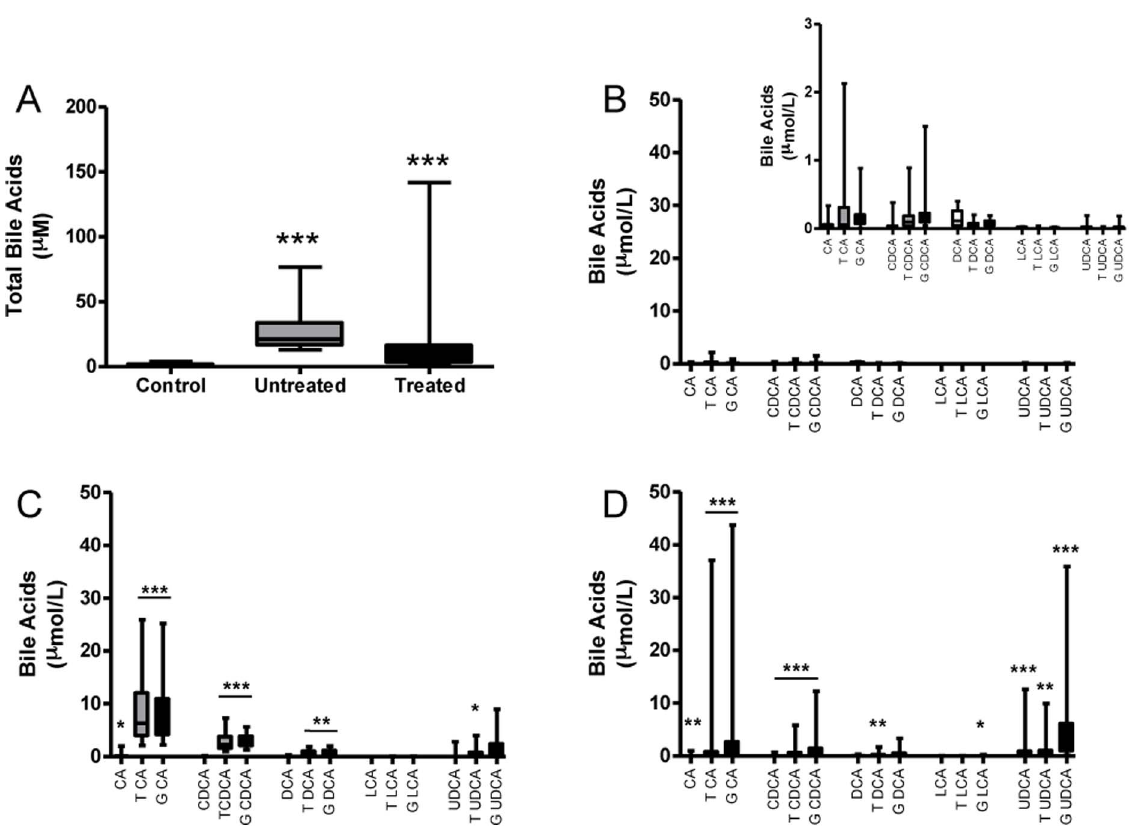
Figure 1. Total serum bile acids and HPLC-MS/MS analysis of bile acid profiles in maternal serum. Total serum bile acids in control, untreated ICP and UDCA-treated ICP maternal serum (A). Maternal serum bile acid profiles in normal (B), untreated ICP (C) and UDCA-treated ICP pregnancies (D). In panels B–D, the serum bile acid level is shown using equivalent Y-axes in each group. However, given the significantly lower levels of bile acids in control serum the inset panel demonstrates these data using a smaller scale. * p= , 0.05, ** p= , 0.001, *** p= , 0.0001. Panel C comparisons vs. control, panel D comparisons vs. untreated ICP.